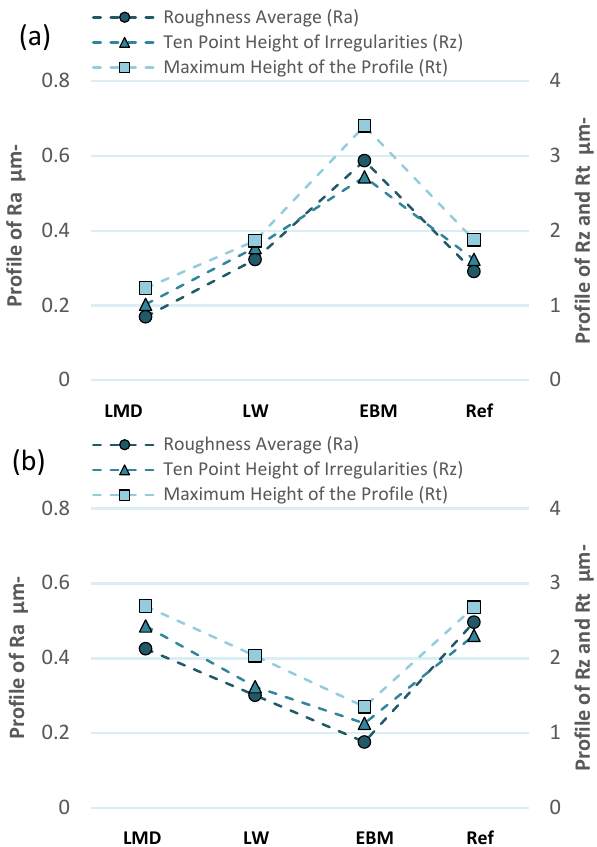
Figure 11. ( a – d ) Profilometry measurements conducted in the machining direction in the IJ-plane. The samples were machined in the I-direction. ( e – h ) Profilometry measurements conducted in the machining direction in the IJ-plane. The samples were machined in the J-direction.